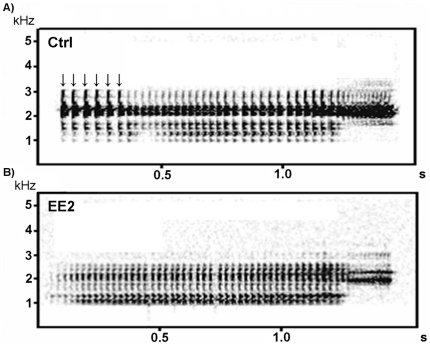
Spectrograms of advertisement calls.A) Advertisement call of an unexposed control male with six accentuated clicks at the beginning of the call, indicated by vertical arrows and B) advertisement call of an EE2 exposed male (2.96 µg/L) with no accentuated clicks at the beginning of the call.